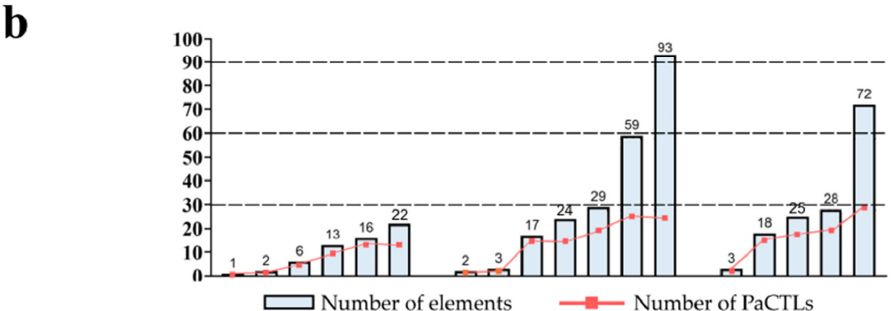
Figure 8. Cis-acting elements analysis in the promoter of PaCTL gene family members. ( a ) Number of each cis-acting element in the promoter region (2 kb upstream of the translation start site) of PaCTLs . The genes marked in blue region were the members of the GH19 subgroup, and the genes marked in red region were the members of the GH18 subgroup. ( b ) Statistics for the total number of PaCTLs , including the corresponding cis-acting elements (red dot) and the total number of cis-acting elements in PaCTL gene family (blue box). Based on the functional annotation, the cis-acting elements were classified into three major classes: plant growth and development-, phytohormone responsive-, or abiotic and biotic stresses-related cis-acting elements.